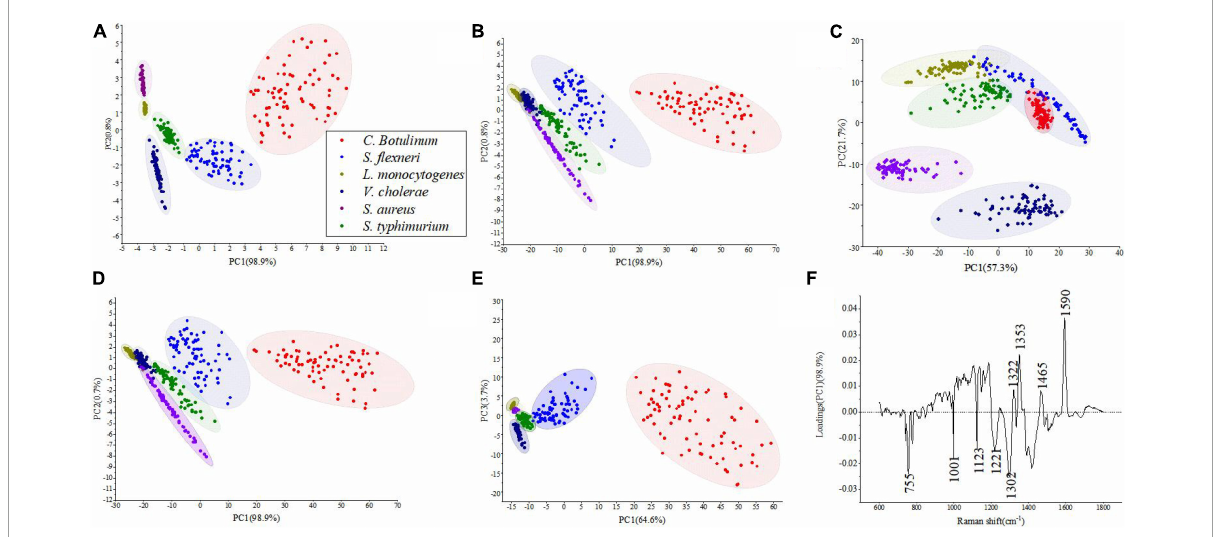
FIGURE4 PCA results obtained for six bacterial species. (A–E) Represent PCA score plots of various preprocess methods, that is, (A) original data, (B) SG, (C) SNV, (D) MSC, and (E) SG 1st Der. (F) A PC-1 loading plot based on the original